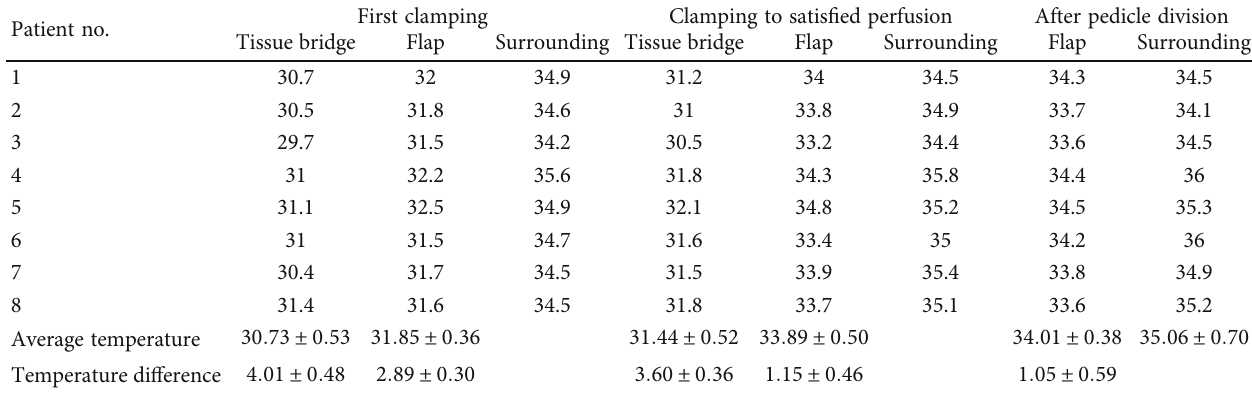
Table 1: Temperature measured with infrared thermography.